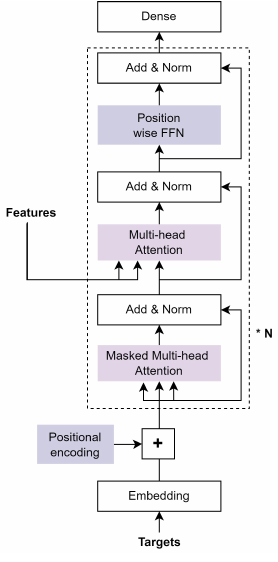
Figure 9. Decoder